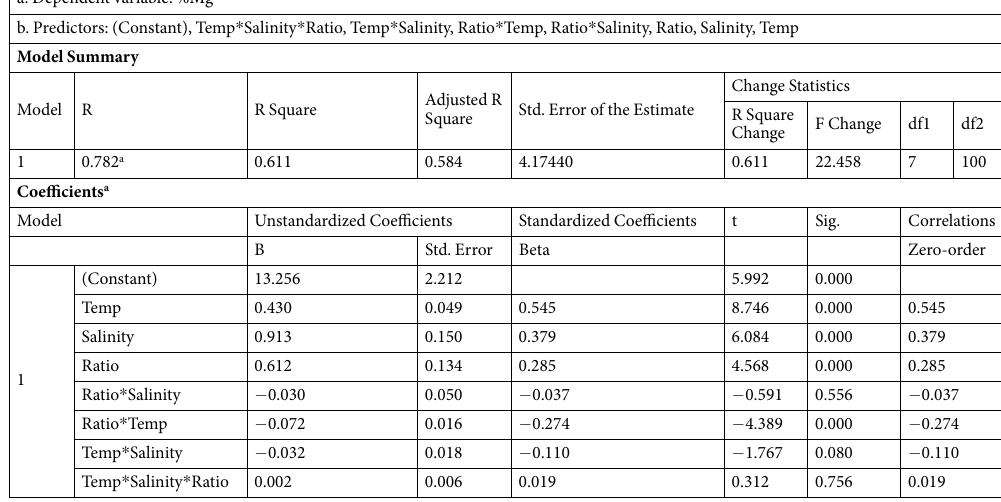
Table 3. Results of multiple linear regression.